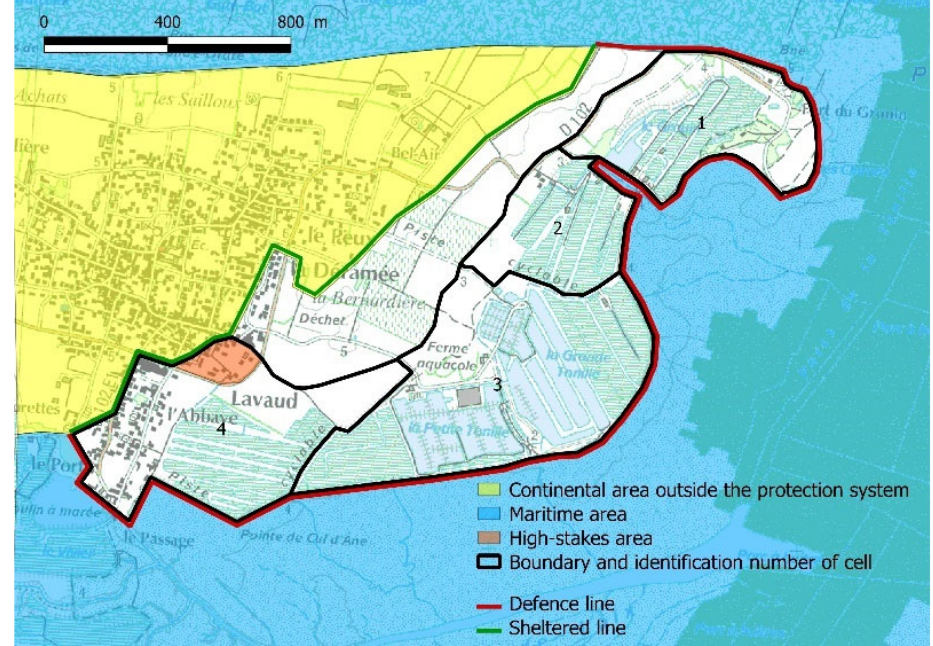
Figure 5. Schematic representation of the Loix protection system.